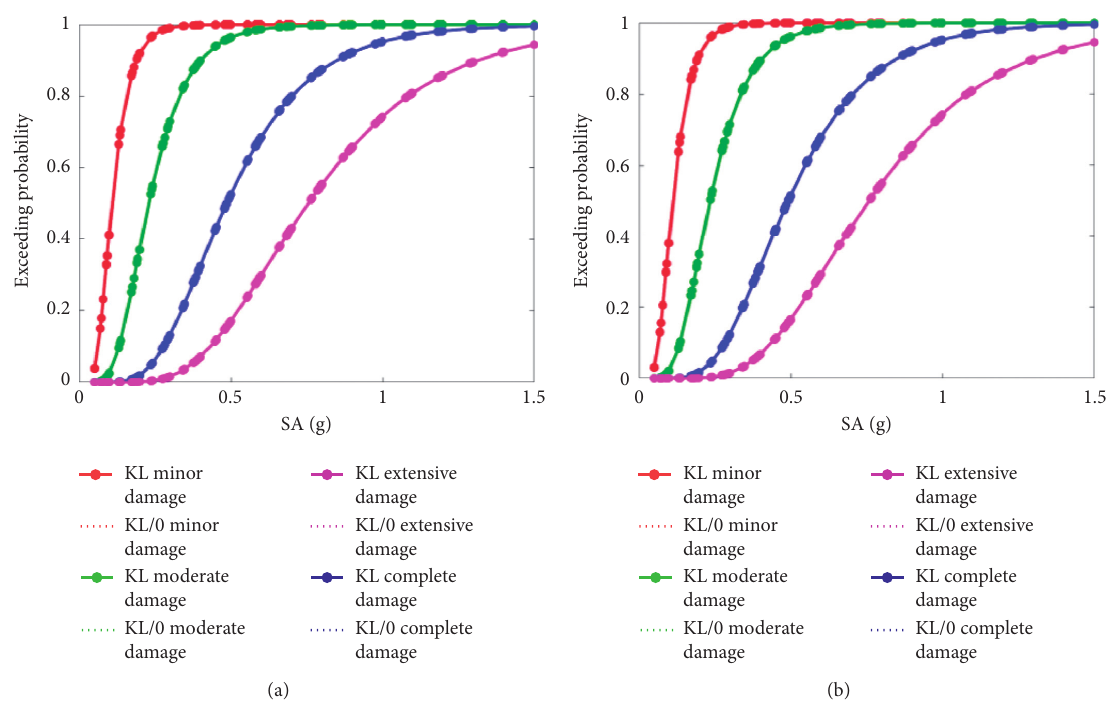
Figure 8: Fragility curves of abutments. (a) Left abutment. (b) Right